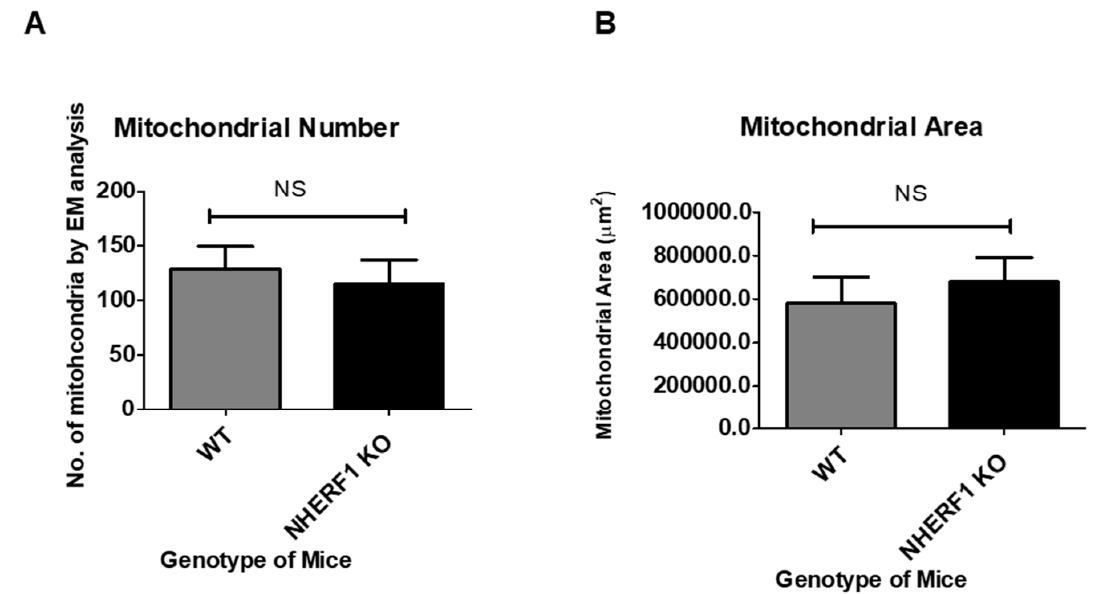
Figure 5. Electron microscopy of mitochondria in WT and NHERF1 KO proximal tubules.